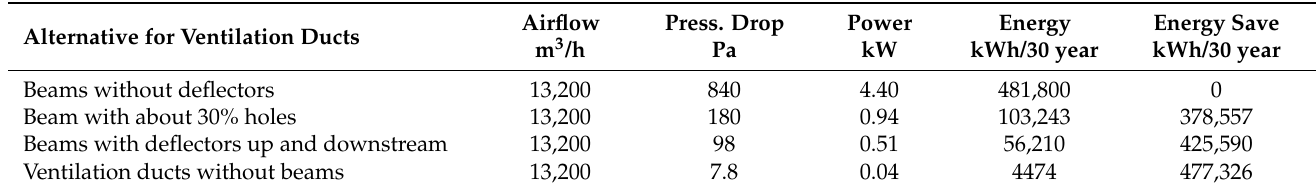
Table 7. Calculation of the power and energy needed to pass the air through the supply and exhaust ventilation ducts with a beam of 388